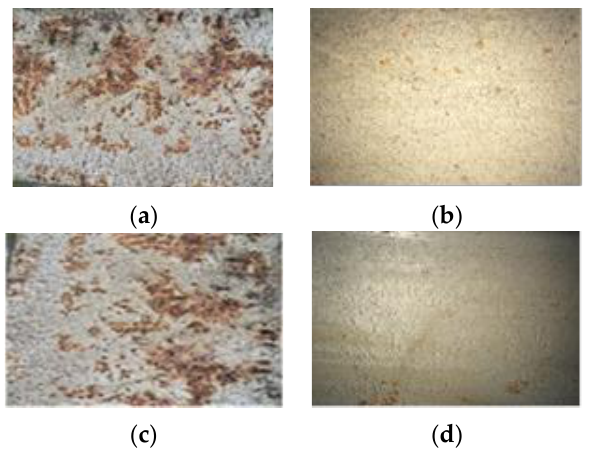
Figure 8. Coating degradation of column ( a ) Ri5 (S5), Y 1 X 1 line; ( b ) Ri4 (S4), Y 1 X 6 line; ( c ) Ri5 (S5), Y 2 X 1 line; ( d ) Ri4 (S4), Y 2 X 8 line. Table 4. Coating degradation evaluation.